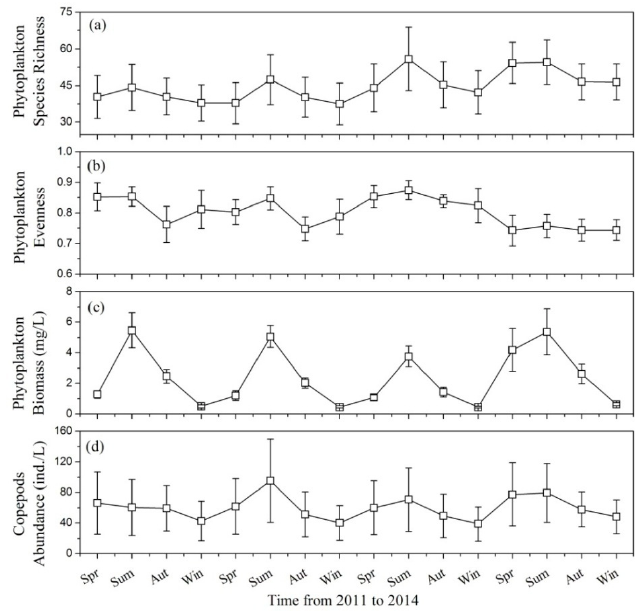
Figure 2. Seasonal variations in ( a ) phytoplankton species richness; ( b ) phytoplankton evenness; ( c ) phytoplankton biomass; and ( d ) copepods abundance. Values are expressed as mean ± standard deviation of the 12 sample sites. Spr: spring, Sum: summer, Aut: autumn, Win: winter. Mean phytoplankton biomass across the study was 2.19 mg/L; however, there were significant seasonal variations (Figure 2c), with mean phytoplankton biomass varying between 0.44 mg/L (winter 2013) and 5.46 mg/L (summer 2011). Chlorophyta was the dominant community in the lake with a mean biomass of 0.94 mg/L, which accounted for 43.0% of the total phytoplankton biomass. The mean biomasses of Bacillariophyta and Euglenophyta were almost equal (0.45 mg/L and 0.43 mg/L respectively). Cyanophyta had a relatively lower mean biomass (0.20 mg/L) and its proportion was 8.92%. Phytoplankton biomasses were notably lower at Sites 6 and 10 than they were at other sites (Figure 3a). Site 8 had the highest proportion of Cyanophyta biomass, and its value reached 12.7%. The biomasses of Chlorophyta at Sites 8 and 9 were higher than that at other sites (Figure 3a). Site 4 had the highest value of Euglenophyta biomass.